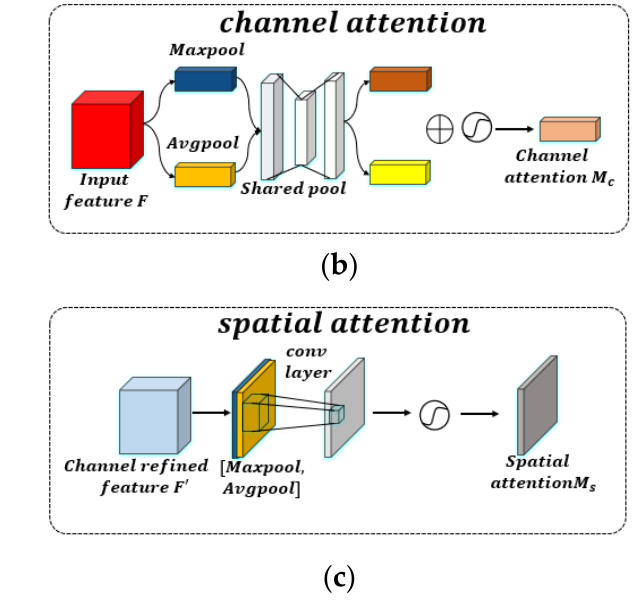
Figure 10. ( a ) CBAM module, ( b ) channel attention module, and ( c ) spatial attention module. The intermediate feature map 𝐹 ∈ ℝ (cid:3004)×(cid:3009)×(cid:3024) acts as the input to infer the 1D channel ∈ ℝ (cid:3004)×(cid:2869)×(cid:2869) and the 2D spatial attention map 𝑀 (cid:3030)